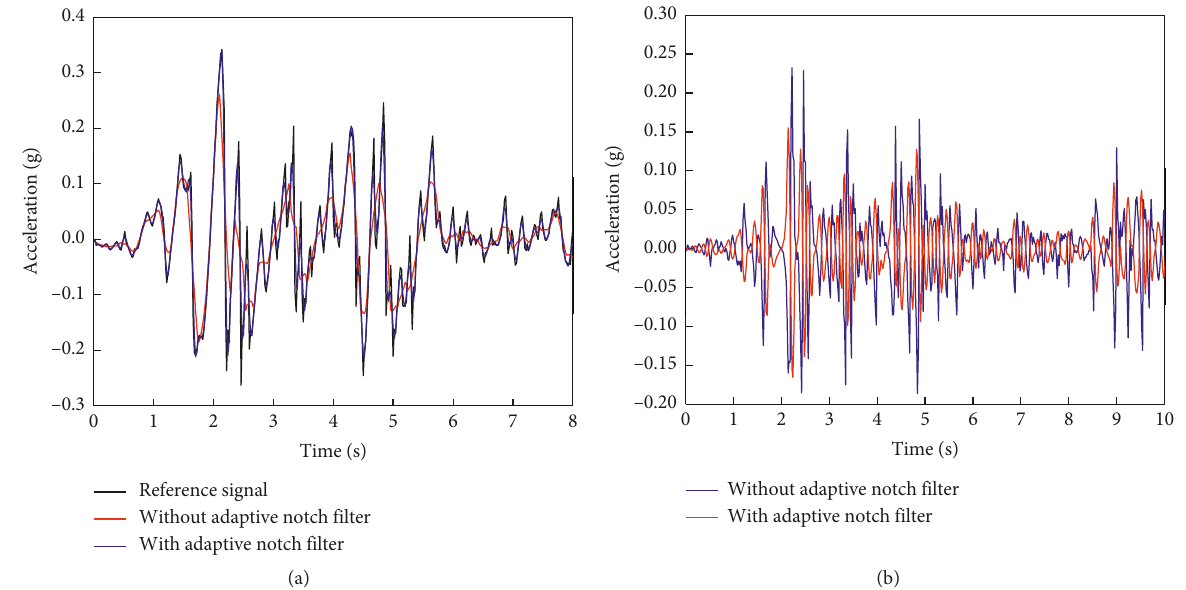
Figure 15: Experiment results of El Centro earthquake wave. (a) Tracking performance. (b) Tracking